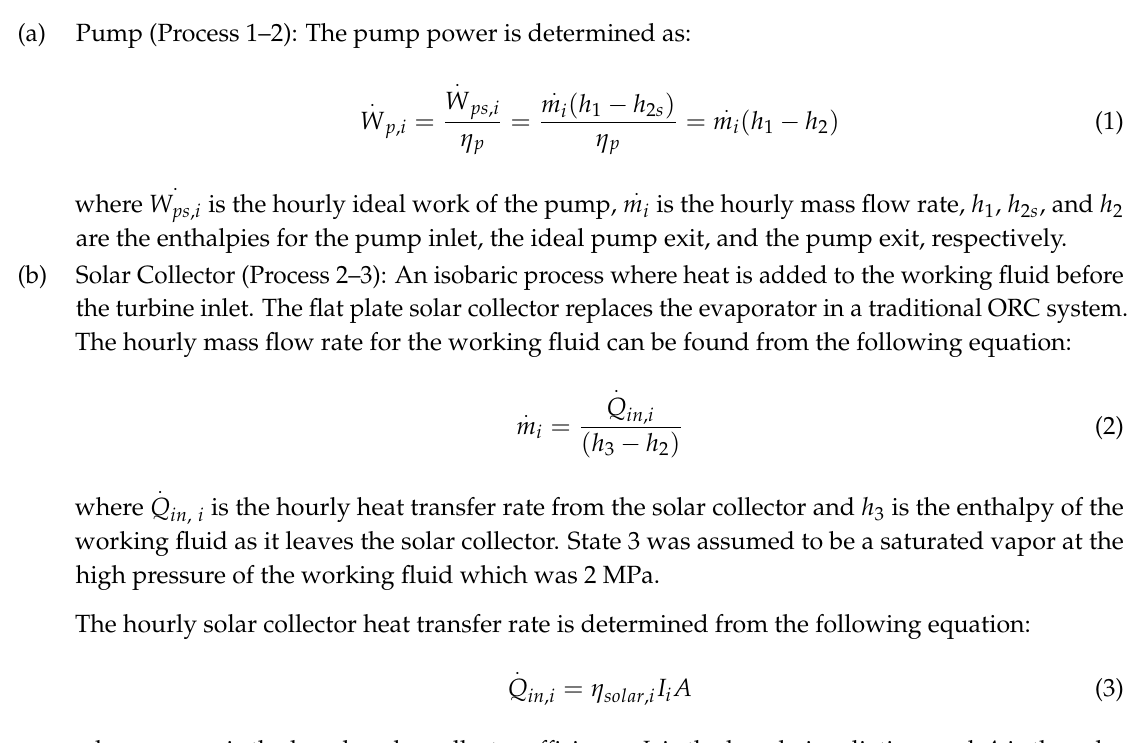
Figure 1. Schematic of the organic Rankine cycle (ORC) with electric storage. EES: electric energy storage. System